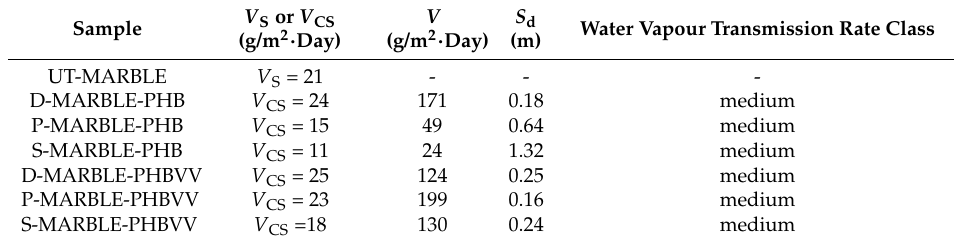
Table 11. Results of water vapour diffusion test for marble treated with PHB and PHBVV and untreated.